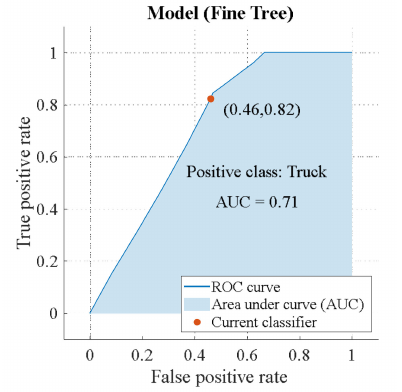
Figure 12. ROC of linear polarization (class “Car”).